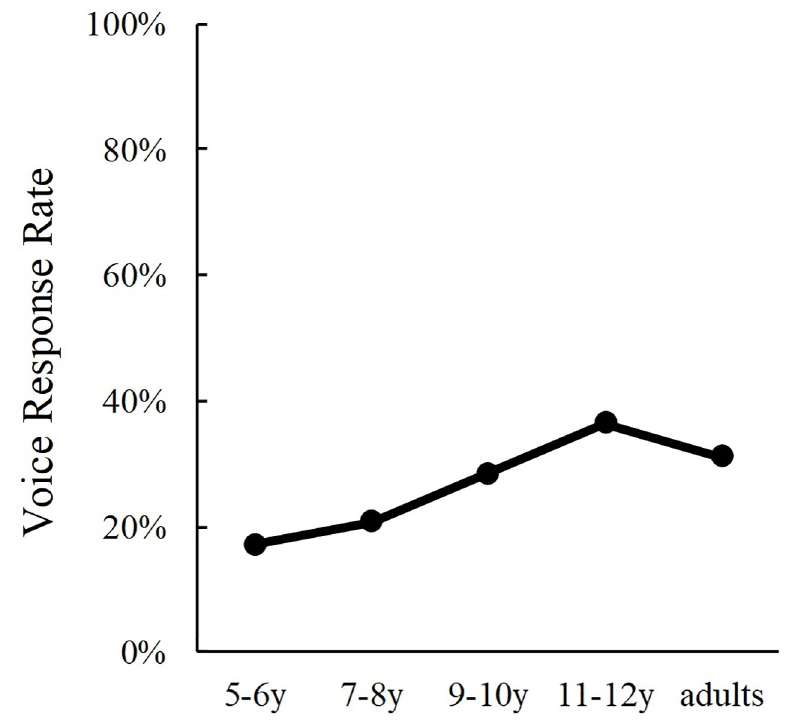
Fig 3. Developmental changes in auditory response rates in the emotion perception